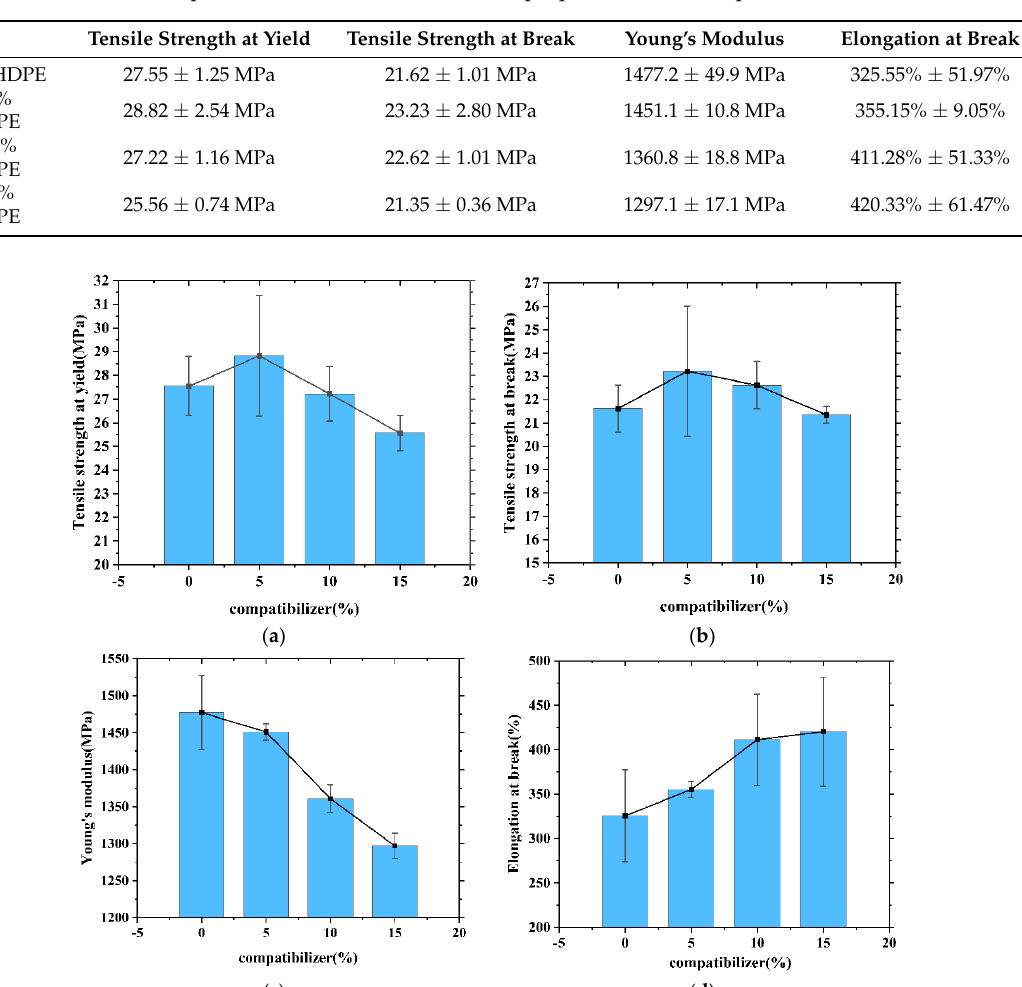
Figure 7. Plot of the effect of compatibilizer percentage on the mechanical properties. ( a ) Tensile strength at yield versus compatibilizer percentage; ( b ) Tensile strength at break versus compatibilizer percentage; ( c ) Young’s modulus versus compatibilizer percentage; ( d ) Elongation at break versus compatibilizer percentage.